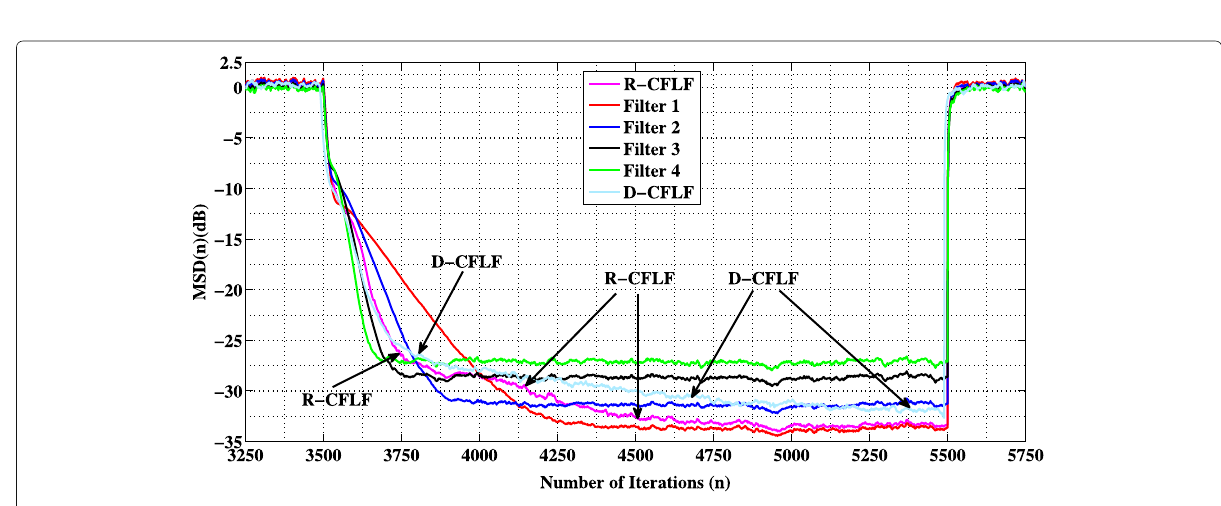
Fig. 13 MSD comparison under nonstationary conditions when input signal is white noise